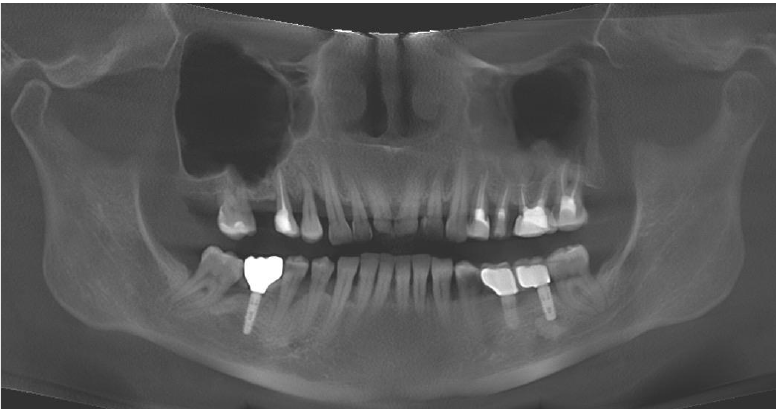
Figure 11. Initial pictures of the patient in case number 2: ( a ) extraoral pictures; ( b ) intraoral pictures.